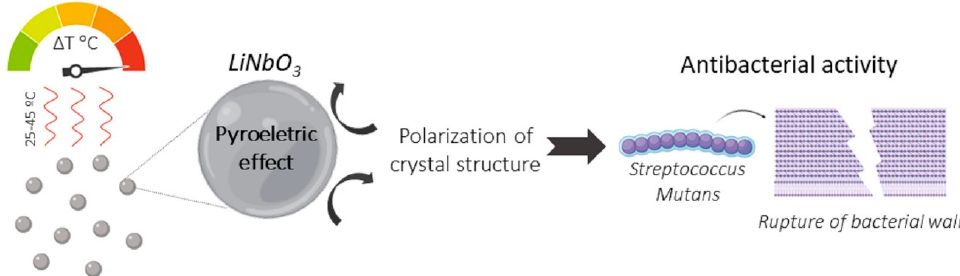
Figure 1. Schematic representation showing the pyroelectric–catalytic e ff ect that occurs at a